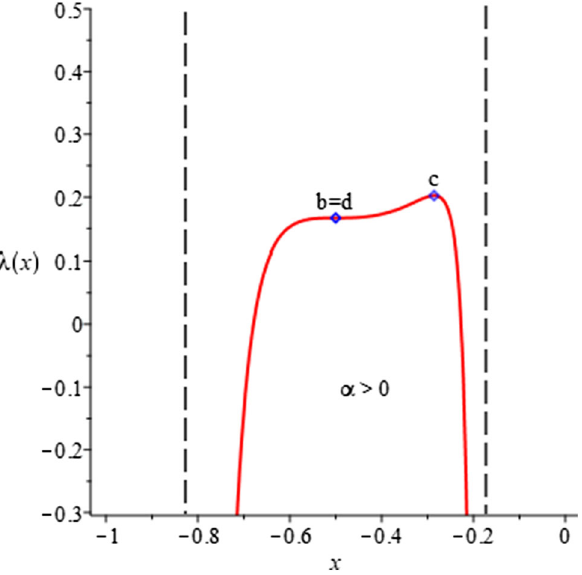
Fig. 2 The function λ( x ) for α > 0, m = 4 and l = 8 [21]